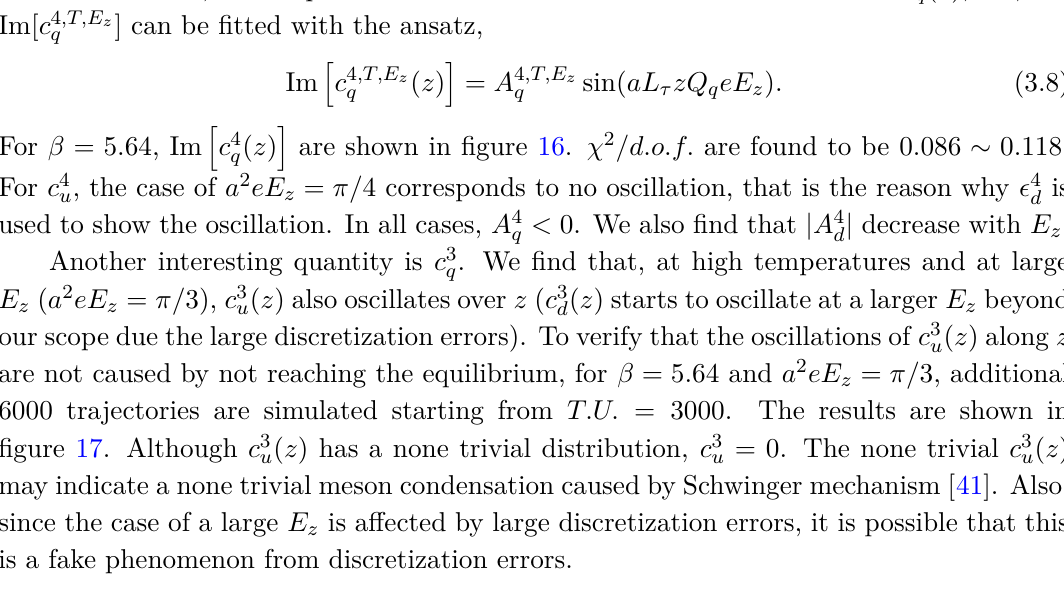
as a function of temperature T and eE d